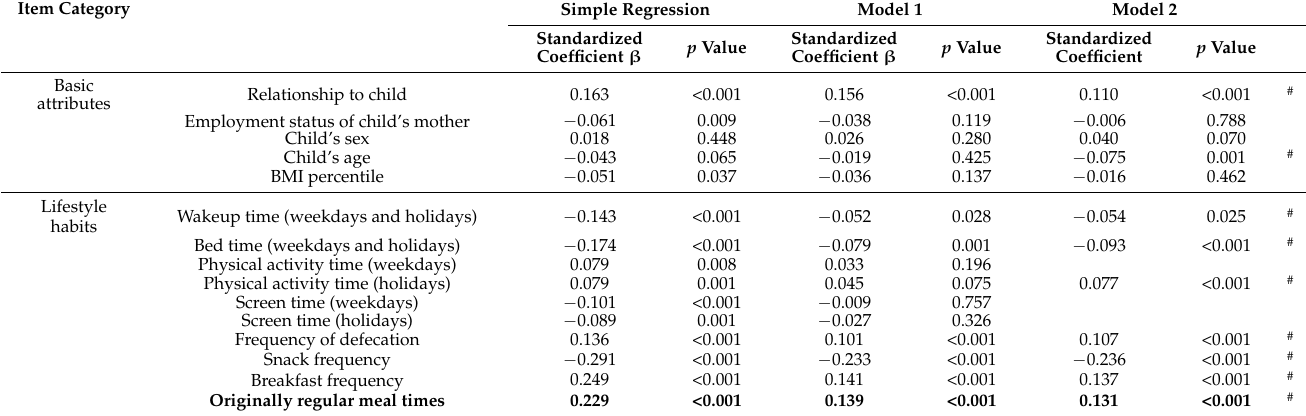
Table 4. Multiple regression analyses with the healthy diet score (HDS) as the dependent